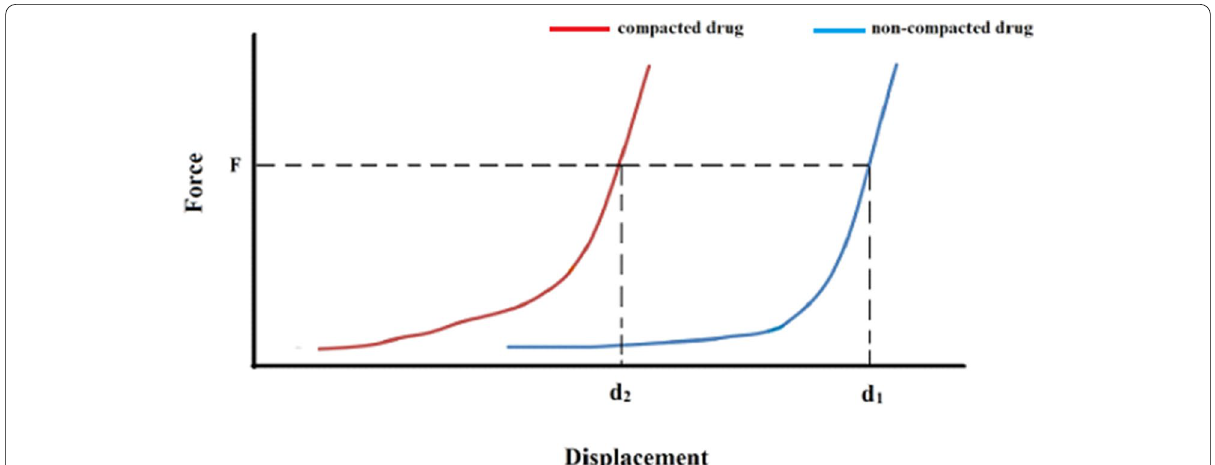
Fig. 12 A sketch representing the effect of changing Kawakita parameters ( P k and a ) on the position of the F-D curve in accord with Eq. 2 when there is a remarkable difference in the maximum volume reduction values between non-compacted and compacted powders